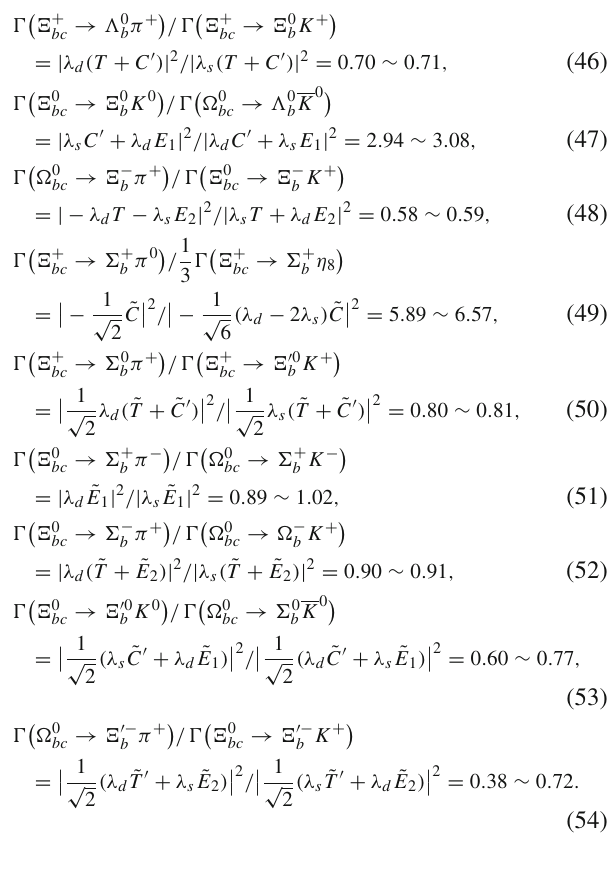
Fig. 3 a The theoretical predictions for the branching ratios of (cid:2) + fractions with η varying from 1.0 to